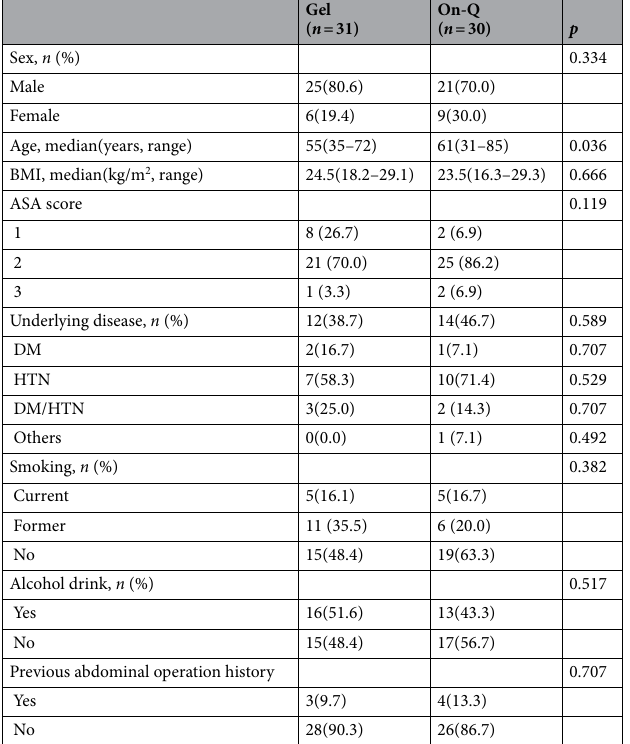
Table 1. Demographic characteristics of patients. ASA American Society of Anesthesiologists, BMI body mass index, DM diabetes mellitus, HTN Hypertension.